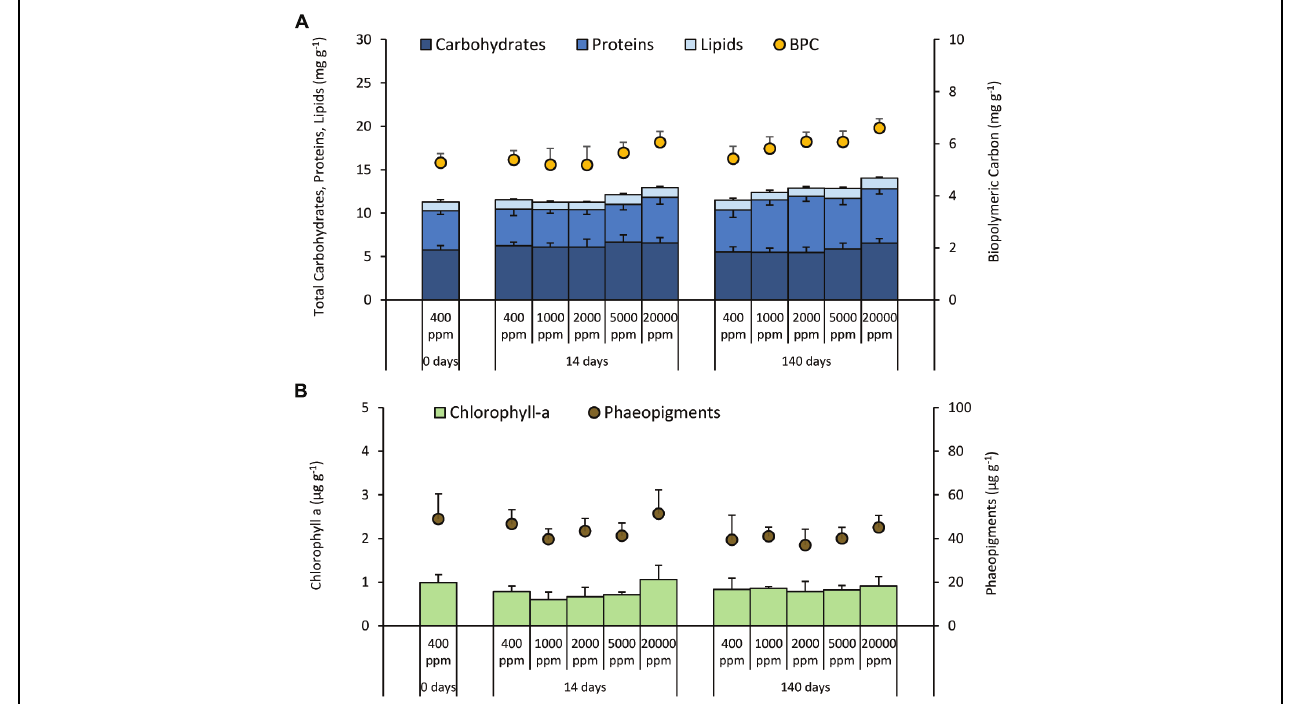
FIGURE 1 | Quantity and quality of the sediment organic matter. Reported are the mean values and relative SDs for (A) Carbohydrate, protein, and lipid content in surface sediments, as well as the sediment concentration of the Biopolymeric Carbon (BPC), and (B) chlorophyll-a and phaeopigment concentration under different high-CO 2 experimental systems (1,000–20,000 ppm) and in the controls (i.e., 400